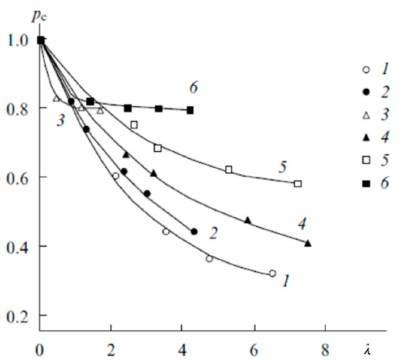
Figure 16. Relative parts of contact ion pairs vs. the moisture content for sulfonate cation-exchange (1–3) and carboxylic (4–6) membranes in various ionic forms. Membrane ionic form: (1, 4) Li + ; (2, 5) Na + ; (3, 6) Cs + . Reprinted with permission from [20]. Copyright 2011